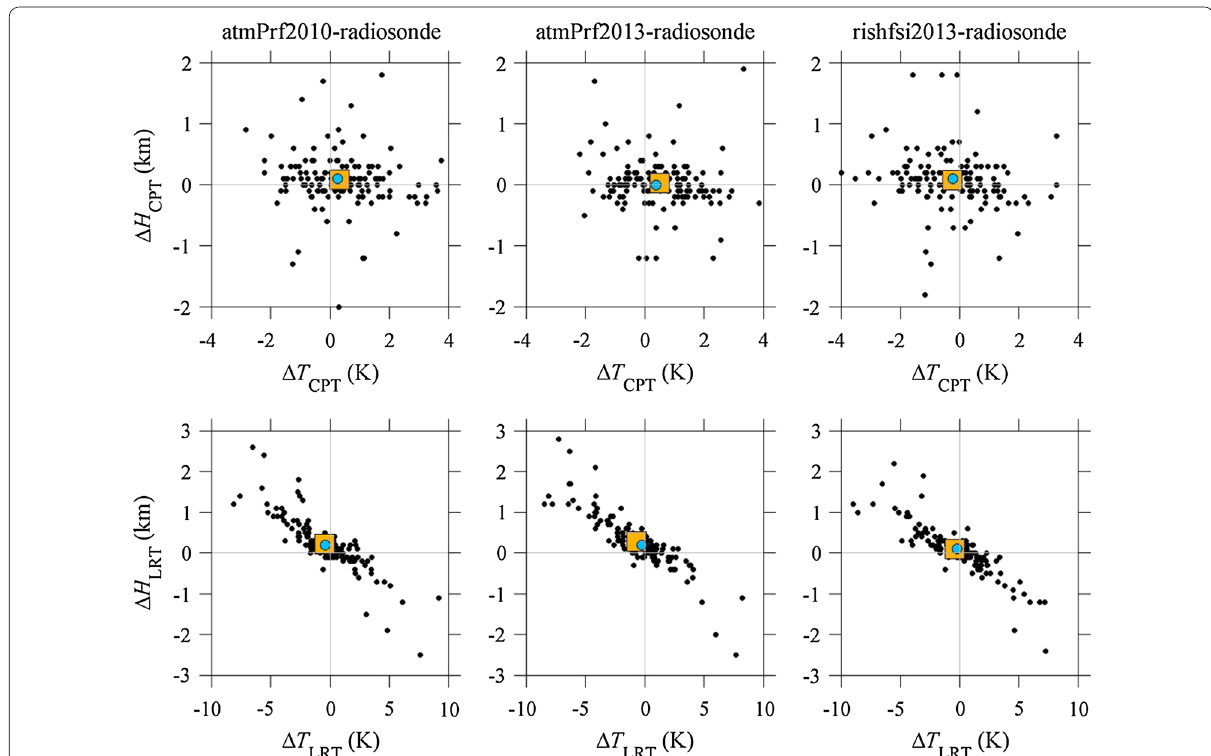
Fig. 10 Scatterplot between ∆ T and ∆ H , GPS-RO minus radiosonde, for CPT ( top panels ) and LRT ( bottom panels ). Left, middle and right panels cor- respond to atmPrf2010, atmPrf2013 and rishfsi2013, respectively. Yellow square and the blue circle show the mean and the median,